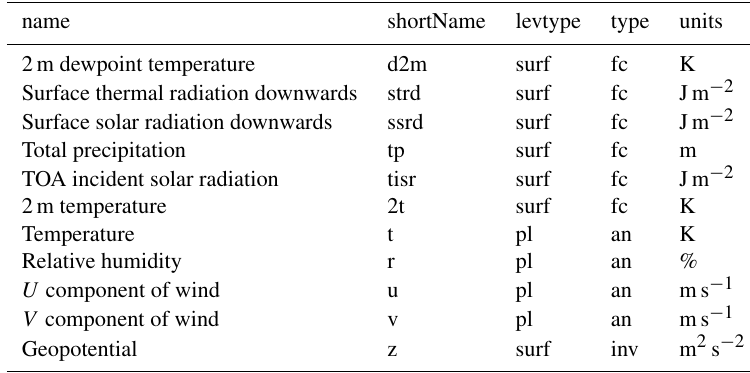
Table 2. Description of the hourly fields obtained from the ERA5 reanalysis. All of the columns headers are terms defined by ECMWF. “levtype” refers to the level type, “surf” refers to the surface and “pl” denotes the pressure level. The “type” is either “fc”, which refers to forecast, “an”, which refers to analysis, or “inv”, which refers to invariant. name